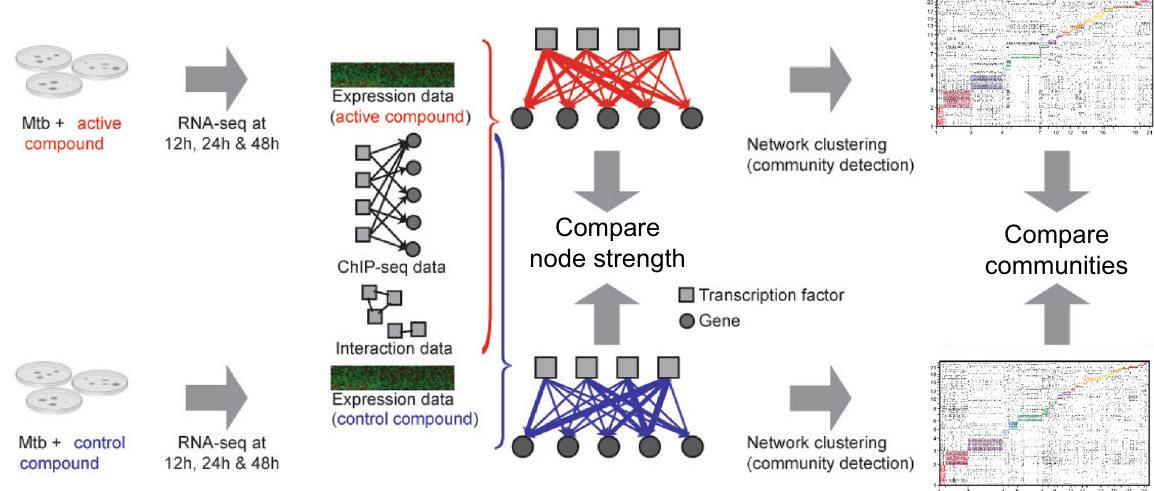
Fig. 1 Summary of the experimental design and network comparisons. Using a message passing framework 9 (see “ Methods ” ) we integrated ChIP-seq and transcription factor protein – protein interaction (PPI) data with condition-speci fi c gene expression data to build kinase inhibitor and control gene regulatory networks. Network edges connect TFs to genes and are weighted to re fl ect the con fi dence (in z -score units) of a regulatory relationship based on the concordance between omics data types. The TF node strength is de fi ned as the sum of all weights for edges emanating from the TF, and gene node strength is the sum of all weights for edges terminating at the gene. The inhibitor and control networks were clustered into groups containing both TFs and genes using bipartite community detection 25,29 as detailed in the “ Methods ” . Table 1. Top ten transcription factors ranked by absolute change in node strength between inhibitor and control networks. P -values are calculated from permutations (see “ Methods ” ). RV Node strength